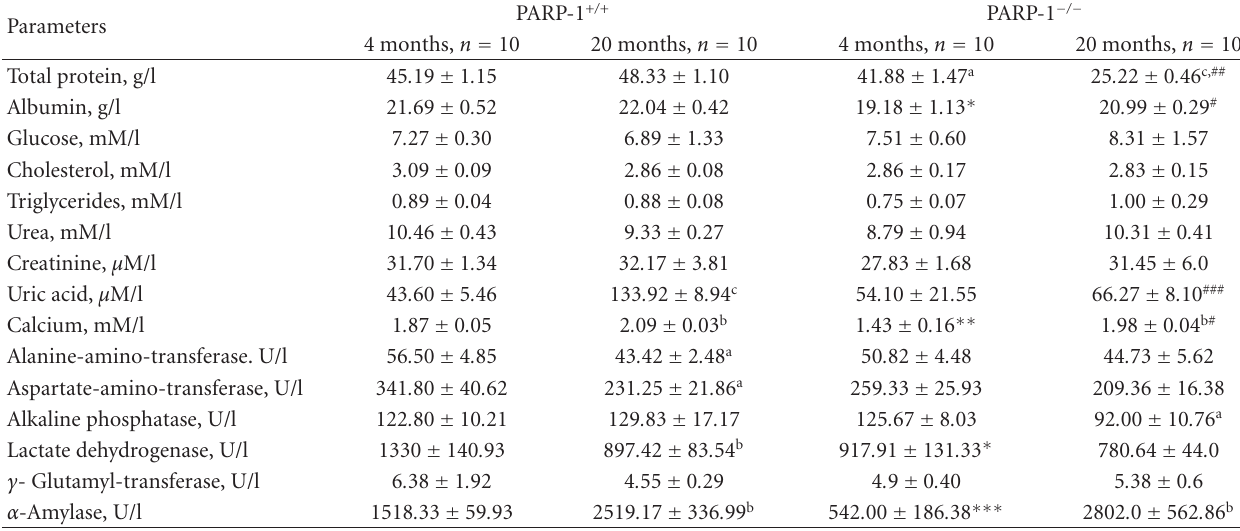
Table 2: Age-related dynamics of biochemical parameters in the serum of PARP-1 − / − and PARP-1 + / + mice.